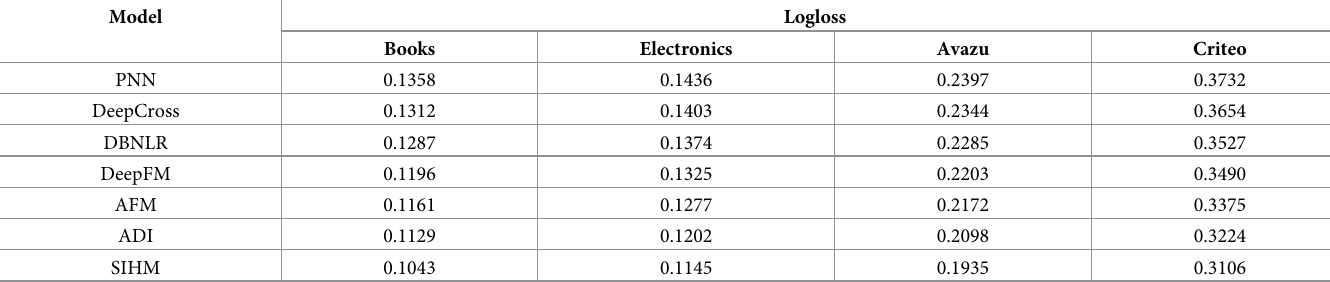
Table 2. Overall CTR prediction for Logloss performance in different datasets. Model